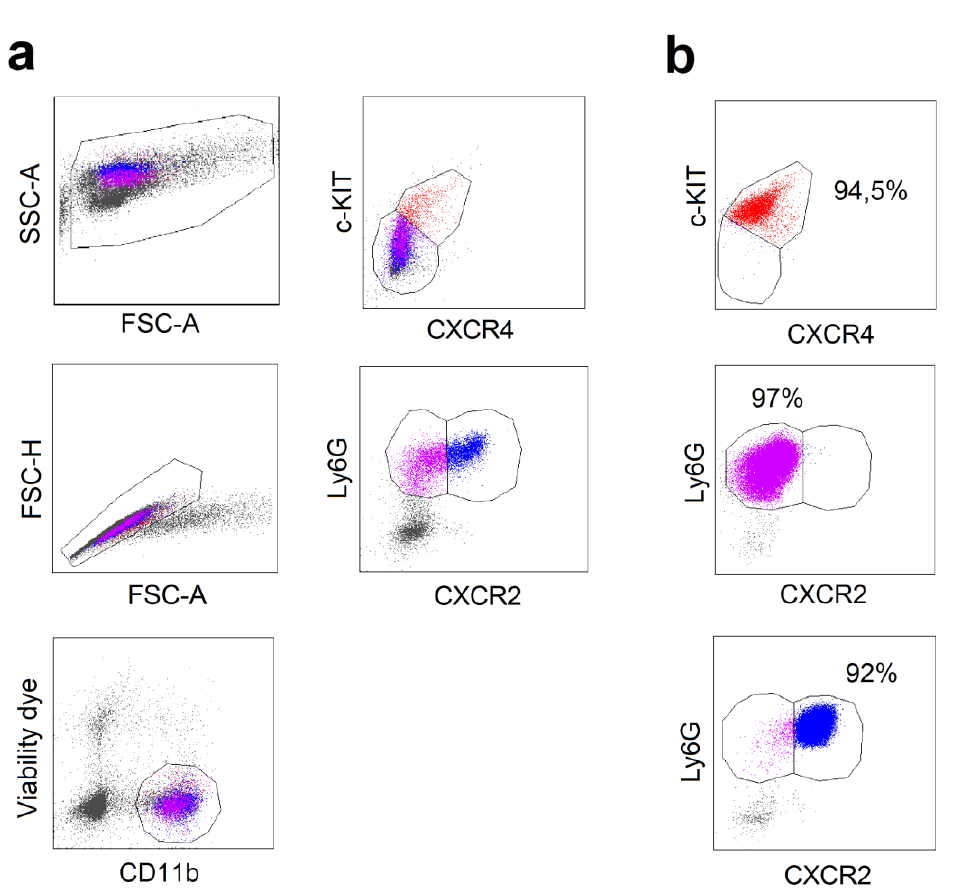
Figure A2. Purity of pre-neutrophils, immature and mature neutrophils isolated from murine bone marrow cell suspension by cells sorting. ( a ) Gating strategy for pre-neutrophils (single viable CD11b + /c-KIT + /CXCR4 + ), immature neutrophils (single viable CD11b + / c-KIT - /CXCR4 - /Ly6G + / CXCR2 - ), and mature neutrophils (single viable CD11b + / c-KIT - /CXCR4 - /Ly6G + /CXCR2 + ); ( b ) Purity of sorted cells > 90%.